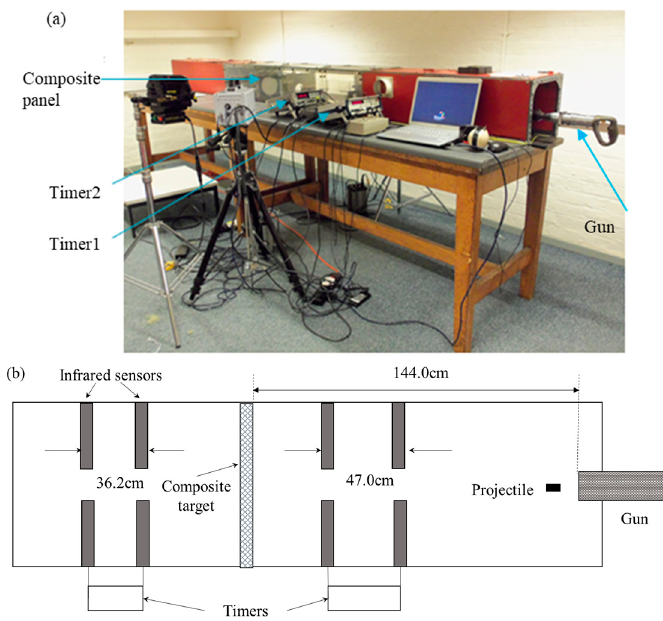
Figure 3. Setup of the ballistic impact: ( a ) Ballistic range; and ( b ) Schematic of the ballistic range for composite ballistic performance evaluation.